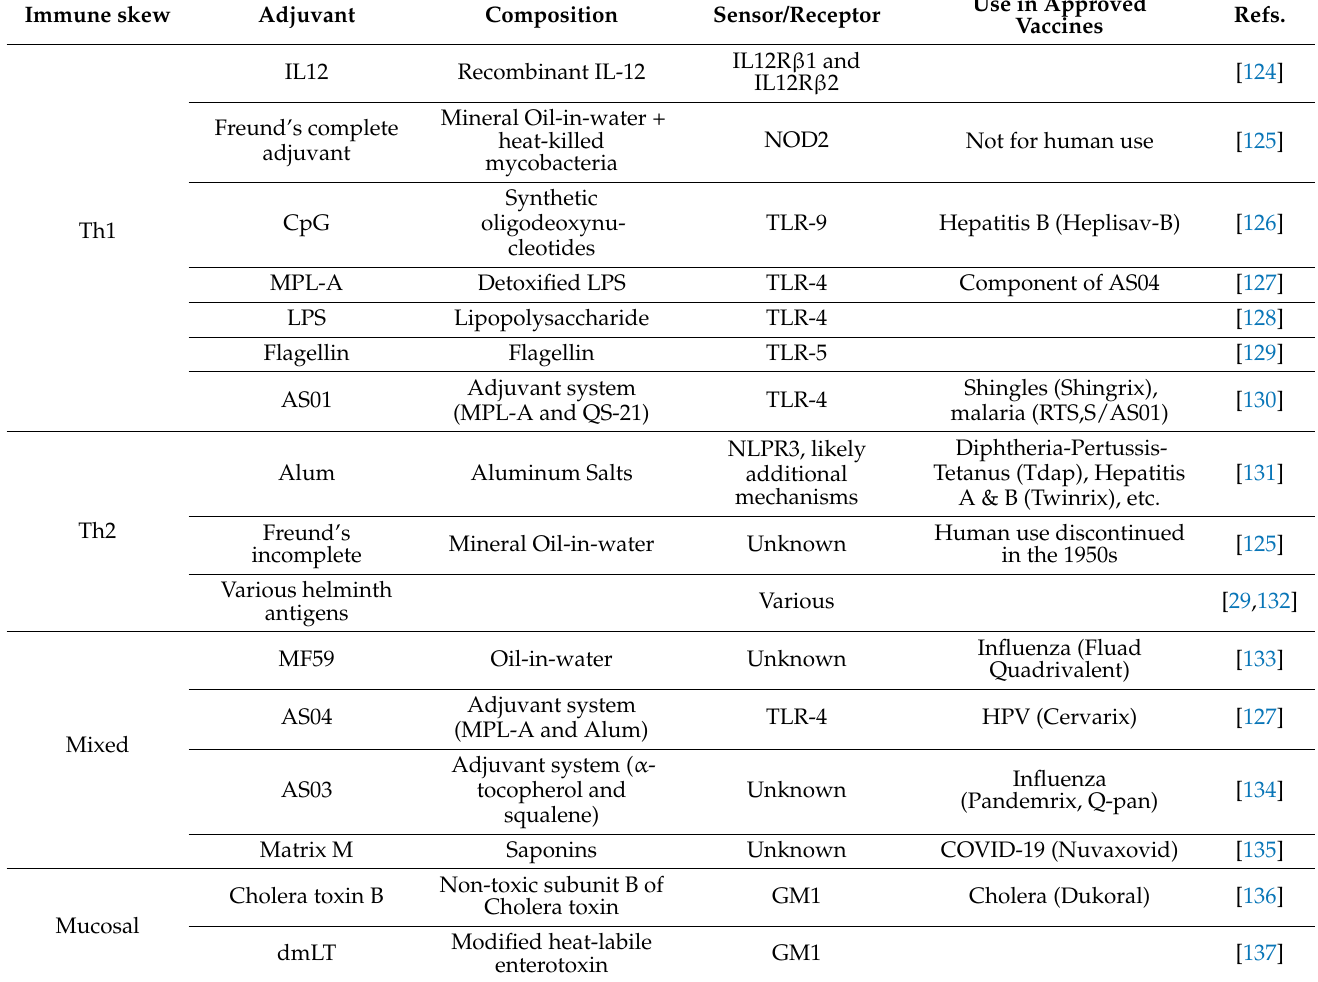
Table 2. A non-exhaustive list of common adjuvants and their properties. Immune skewing effects are noted. However, the vaccine itself, as well as the route of administration, will have an effect on the skew as well. For a thorough summary of currently approved vaccine adjuvants, see [123]. Use in Approved Sensor/Receptor Vaccines